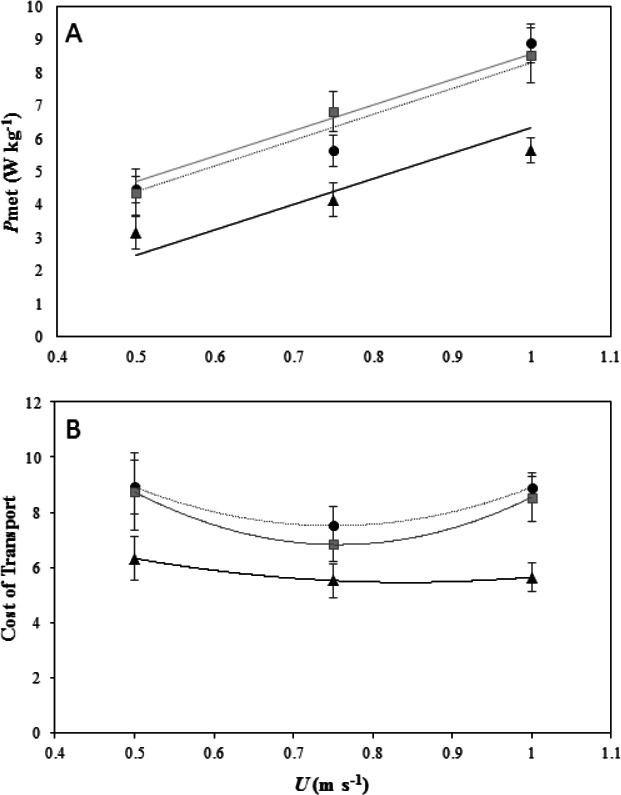
Energetics of locomotion for peacocks moving of different incline.(A) Net Mass-specific power consumption (Pmet, mean ± s.e.m) plotted against forward speed (U) on a level treadmill (black dotted line and black, triangle markers), on a 5° incline (black dotted line and black, circle markers), and on a 7° incline (grey solid line and grey, square markers). All 6 birds performed the first 2 speeds on the level and at each incline and 4 birds performed the top speed at the highest incline. The lines fitted through the data are from the LME model output and are Pmet = − 1.40 + 7.74U for peacocks moving on a level gradient, Pmet = 0.53 + 7.74U for peacocks moving on a 5° incline and
Pmet = 0.53 + 7.74U for peacocks moving on a 7° incline. (B) The minimum cost of transport (MCoT) plotted against forward speed (U) on a level treadmill (black dotted line and black, triangle markers) and at inclines of 5° (black dotted line and black, circle markers) and 7° (grey solid line and grey, square markers). The MCoT, used to calculate the cost of lifting (CoL), was found at 0.75 m s−1 in each gradient treatment.